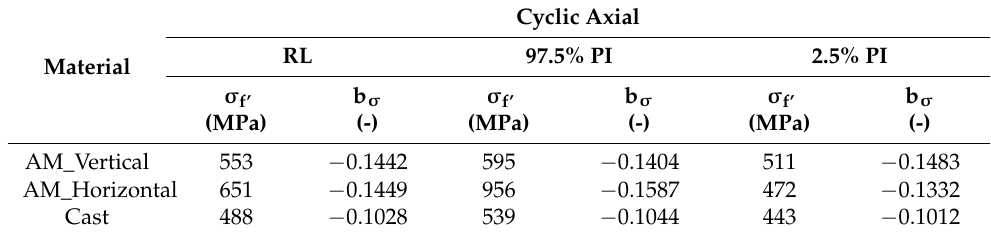
Table 3. Cyclic material